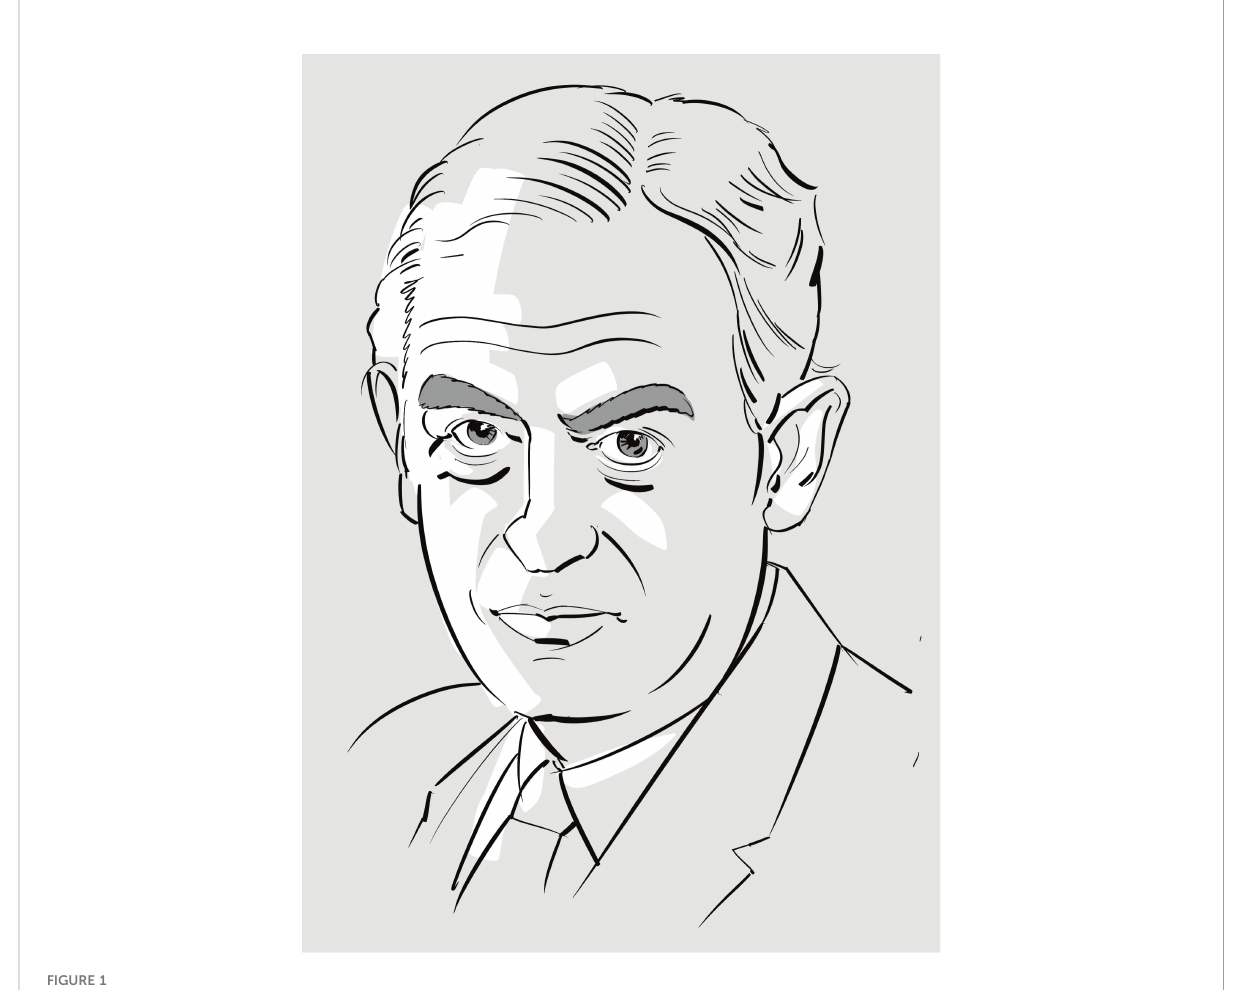
FIGURE 1 Sir Peter Medawar: 1915-1987 and